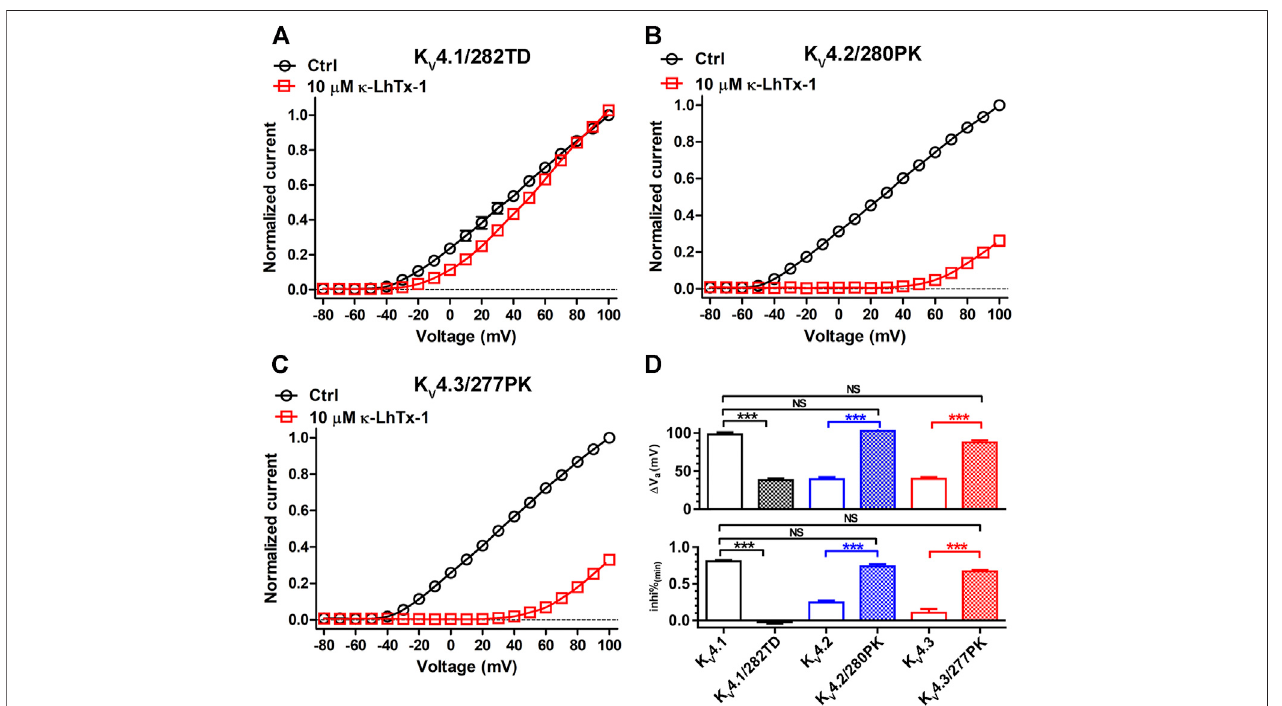
FIGURE 5 | The synergistic action of involved key residues. (A – C) , The I-V curves of K V 4.1/282TD (A) , K V 4.2/280PK (B) and K V 4.3/277PK (C) before and after 10 μ M κ -LhTx-1 treatment (n (cid:2) 5 – 6). Currents at all voltages were normalized to the control current (before toxin treatment) at +100 mV in each group. K V 4.1/282TD, K V 4.2/280PKandK V 4.3/277PKmutantsweremadebymutatingP282/K283toT282/D283inK V 4.1,T280/D281toP280/K281inK V 4.2andT277/N278toP277/K278 in K V 4.3, respectively. (D) , The statistical diagram of the Δ V a and inhi% (min) values of wild-type K V 4 channels and mutants referred in this Figure, showing K V